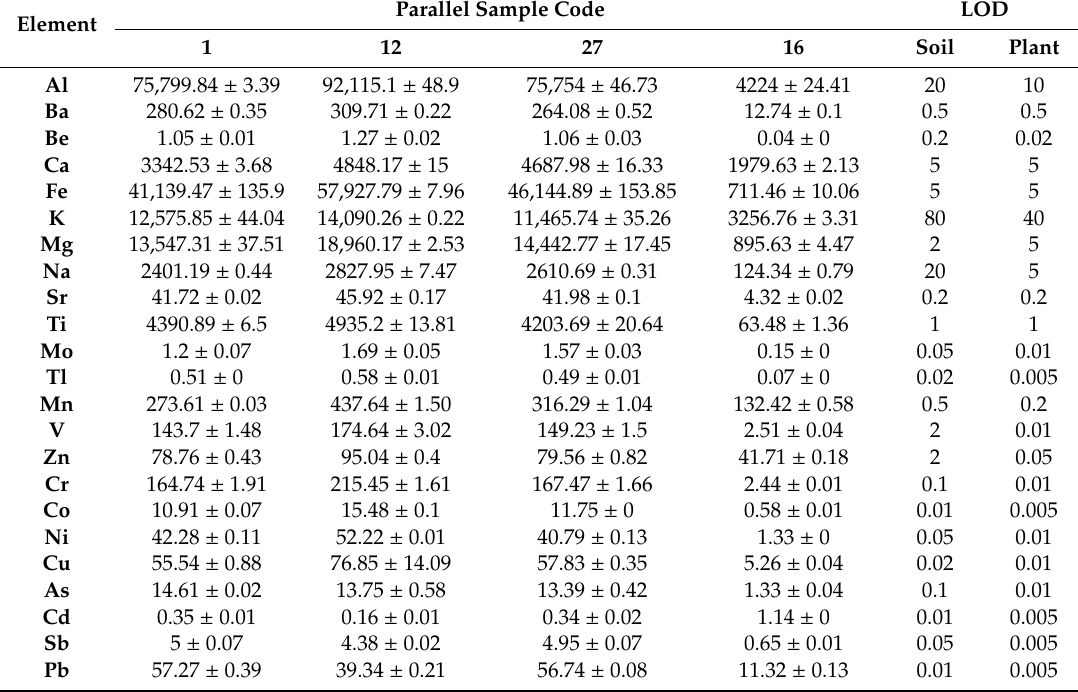
Table 2. Replicate analyses of element contents (mg · kg − 1 ) with 4 parallel samples expressed as mean ± standard deviation and the 23 major and trace elements’ limit of detection